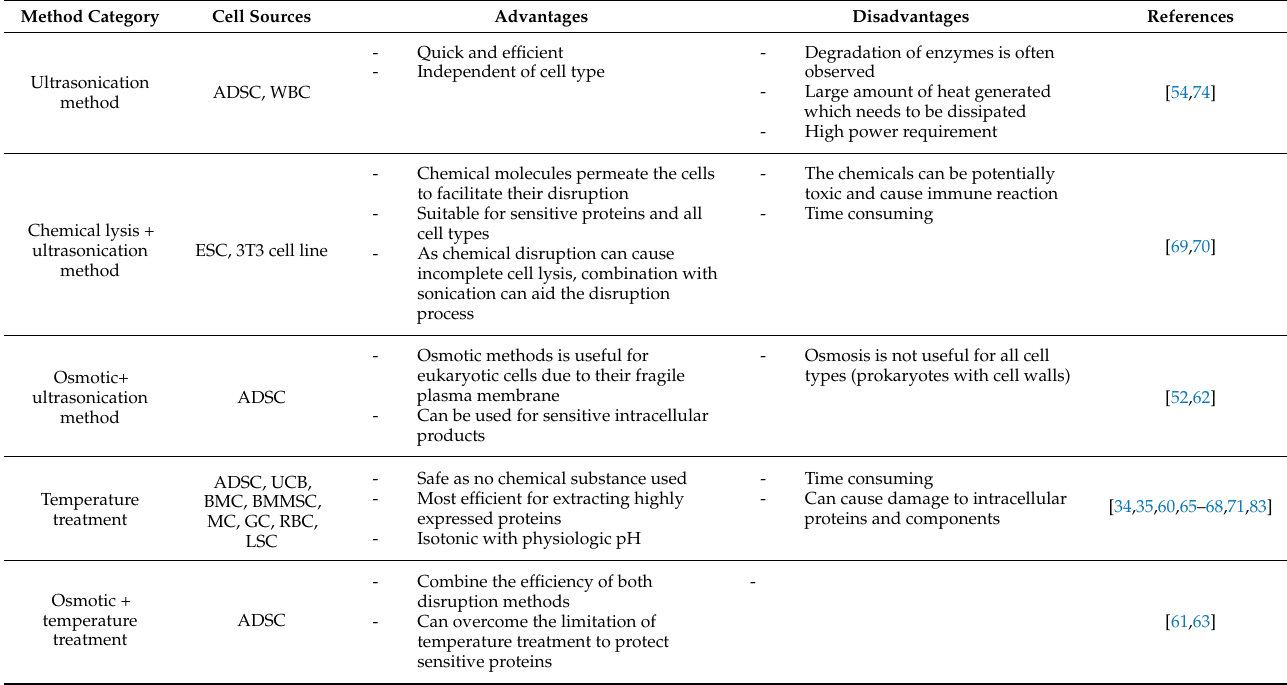
Table 4. Methods for preparing mammalian cell extracts (for a more detailed methodology, readers should refer to Islam et al., 2017)